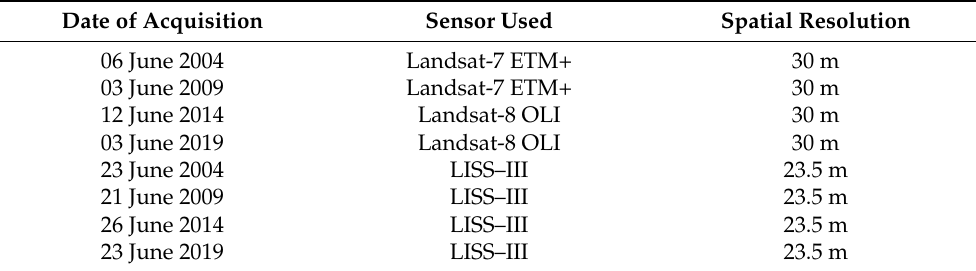
Table 1. Landsat Enhanced Thematic Mapper (ETM+), Operational Land Imager (OLI) imageries and Linear Imaging Self Scanning Sensor- 3 (LISS III) used in this